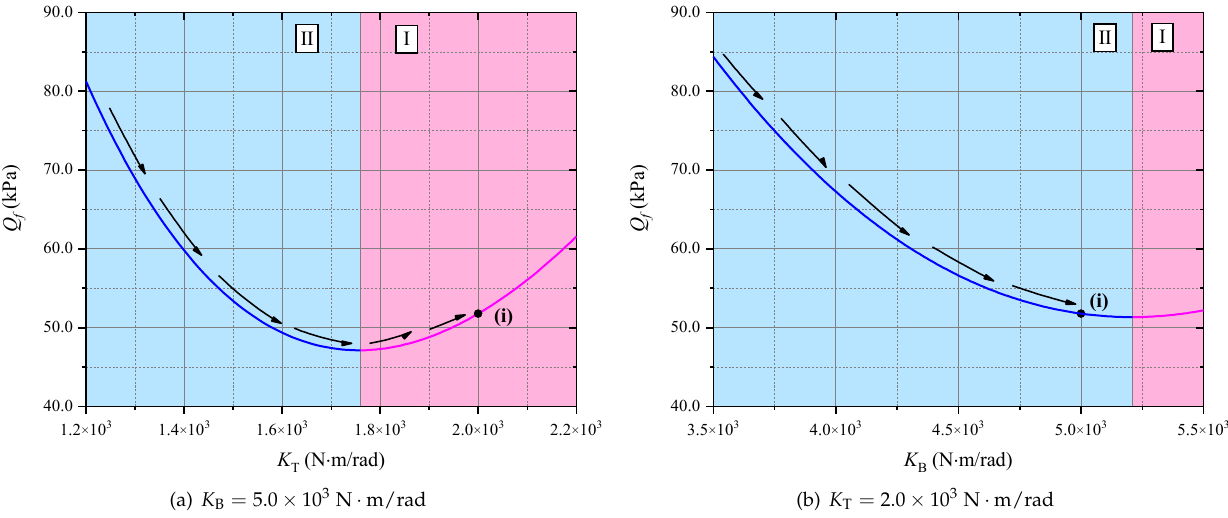
Figure 4. Linear flutter dynamic pressure with the variation of torsional or bending stiffness. (I: monotonically increasing; II: monotonically